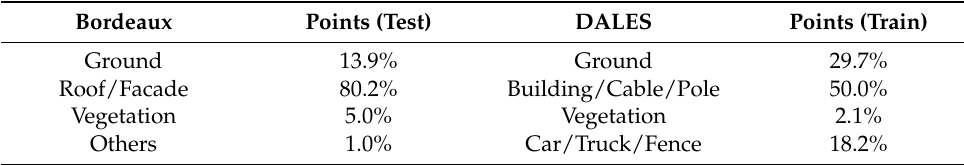
Table 18. Corresponding classes between Bordeaux and DALES datasets.